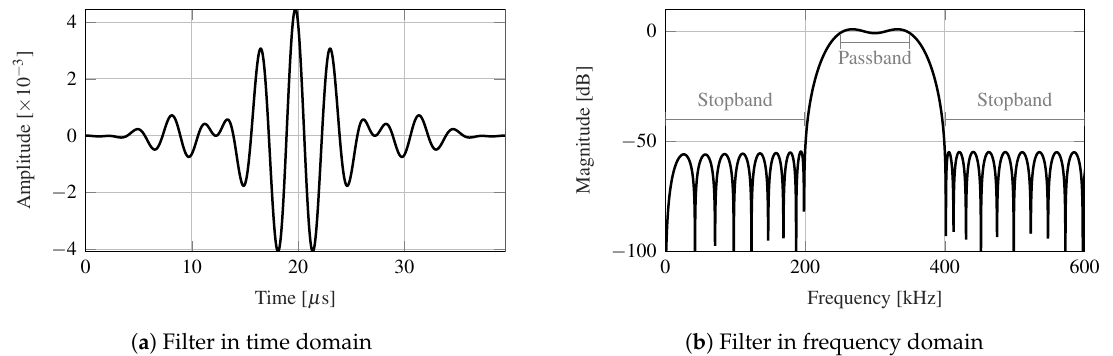
Figure 5. Time (panel ( a )) and frequency (panel ( b )) domain representations of the bandpass